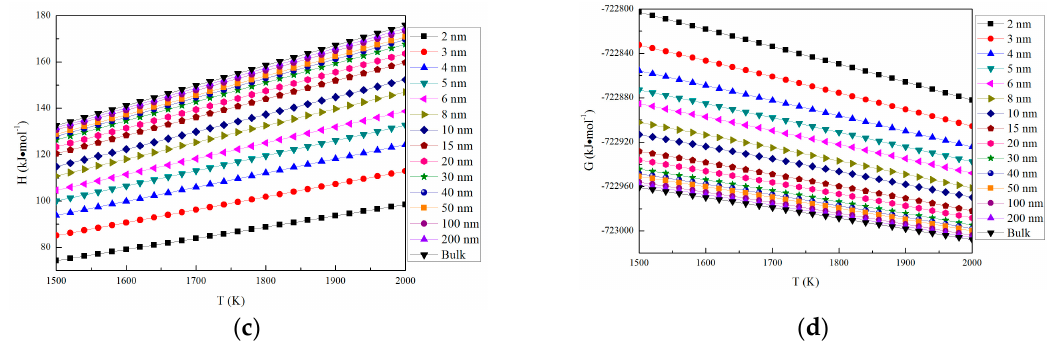
Figure 3. Thermodynamic properties of nano-MgO and MgO (bulk). ( a ) S; ( b ) C P ; ( c ) H; and ( d ) G.